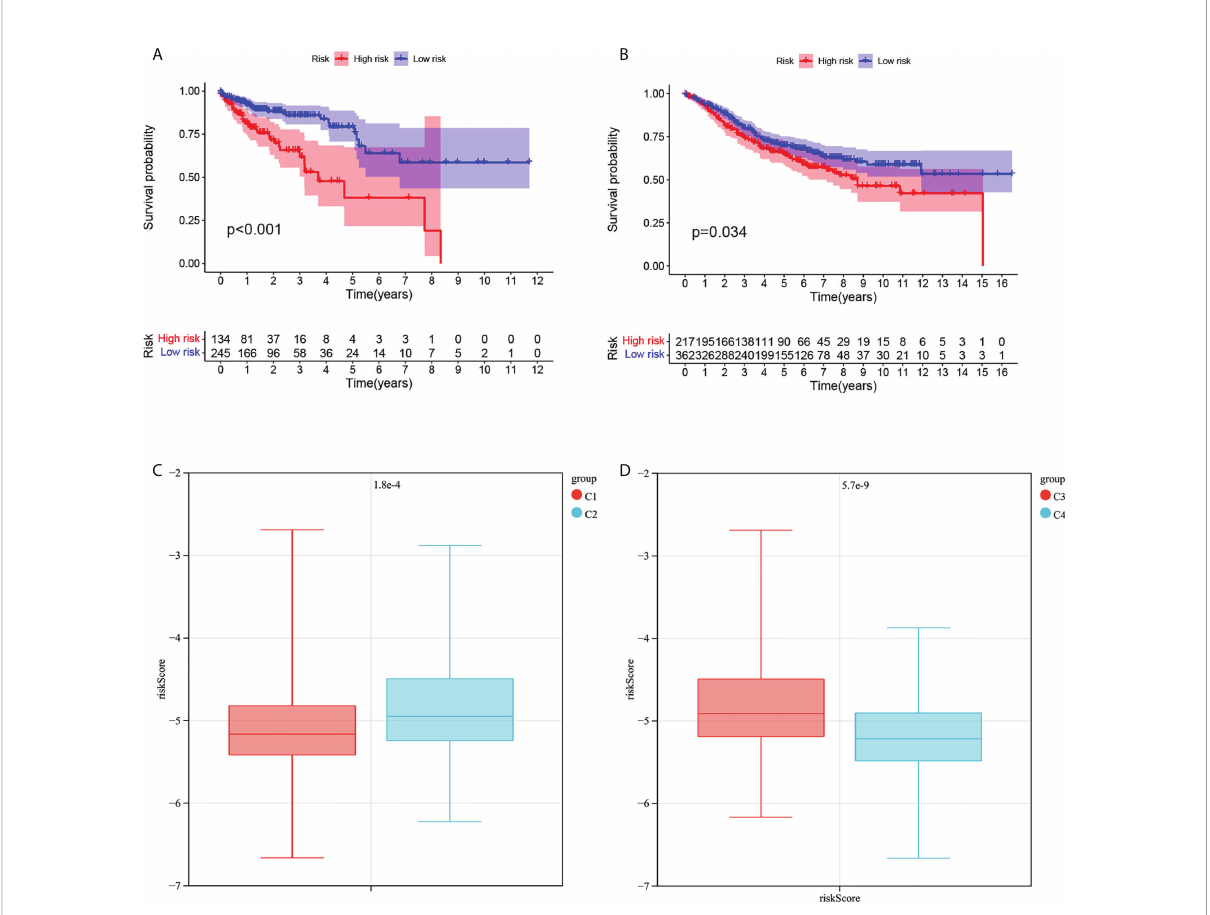
FIGURE 7 Survival analysis of risk models and correlation with COAD subtypes. (A) Analysis of survival differences between high-risk and low-risk COAD patients in TCGA database. (B) Analysis of survival differences between high-risk and low-risk COAD patients in GSE39582. (C) The correlation of risk score with the MMRG pattern. (D) The correlation of risk score with the MMRG-related gene